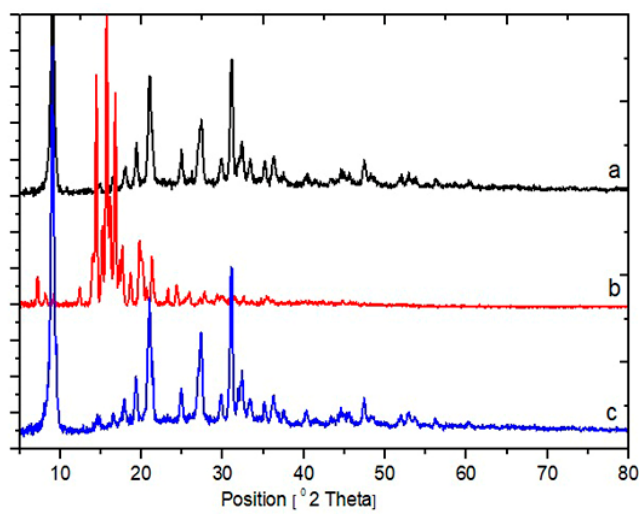
Figure 4. X-ray diffractograms of ( a ) MT, ( b ) HACSLA-NPs and ( c )